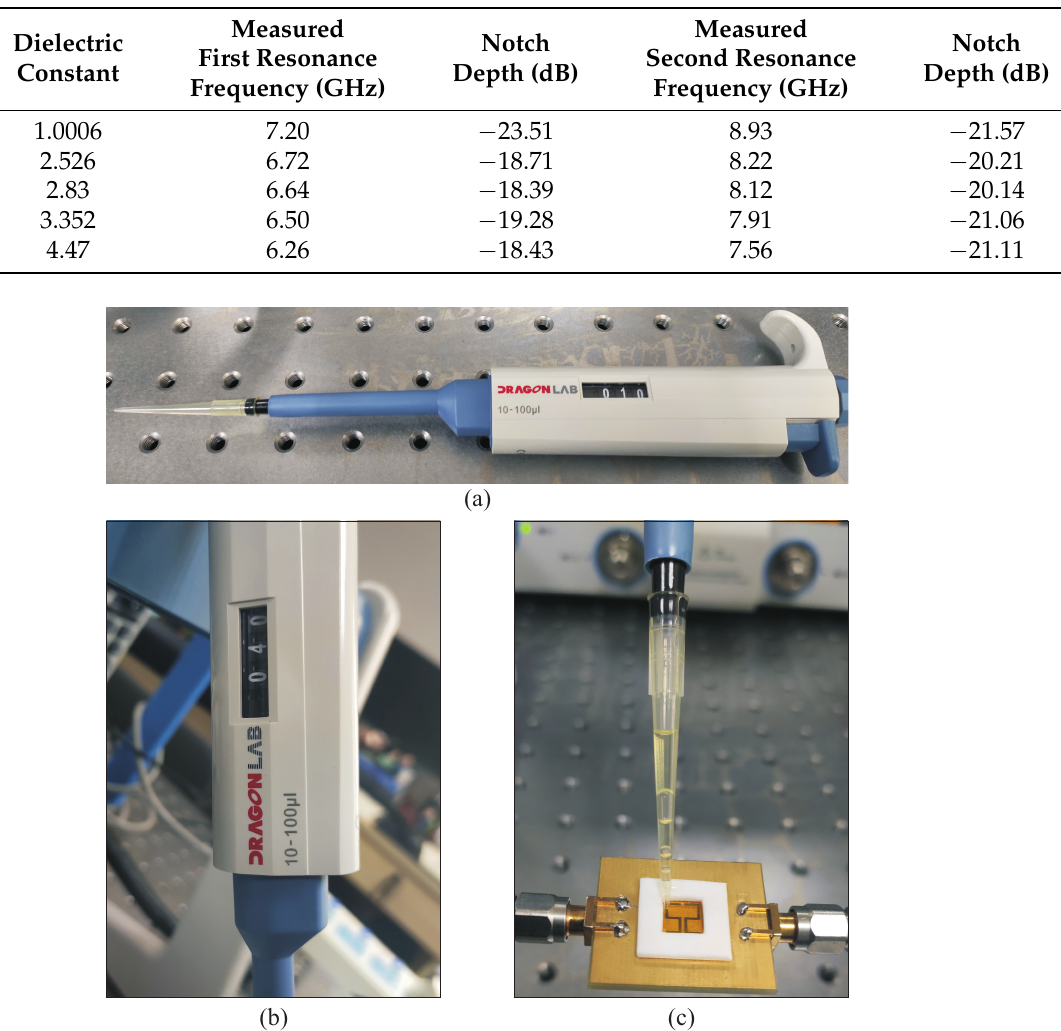
Table 3. Measured S 21 for the complementary metaresonator sensor due to interaction with different OUT.